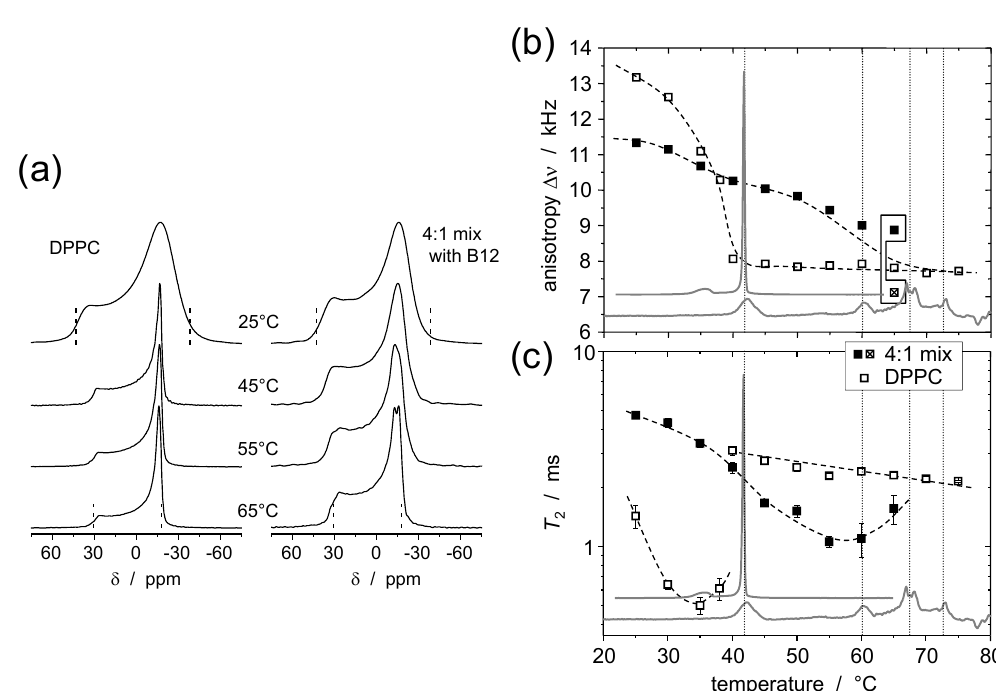
Figure 19. ( a ) Static 31 P spectra of MLVs of DPPC, pure and as a 4:1 mixture with B12 taken at different temperatures. The dashed lines highlight the apparent spectral narrowing on going from the gel to the fluid L α phase; ( b ) Temperature-dependent width of the spectra ∆ ν = 3 and ( c ) temperature-dependent T 2 relaxation times from Hahn-echo experiments evaluated for (cid:104) β (cid:105) ≈ 55 ◦ . DSC traces are shown in the background in grey. Figure reproduced with permission from ref.